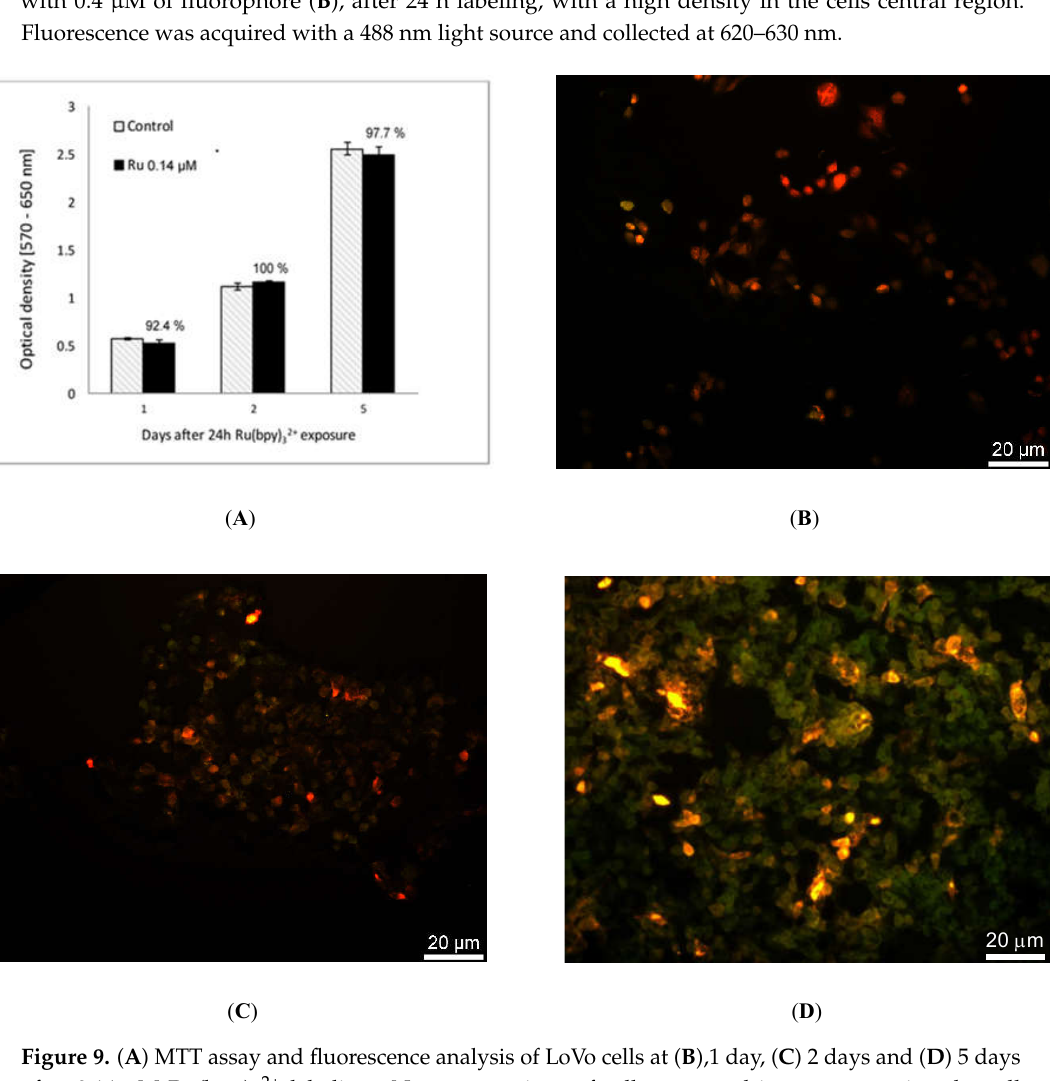
Figure 9. ( A ) MTT assay and fluorescence analysis of LoVo cells at ( B ),1 day, ( C ) 2 days and ( D ) 5 days after 0.14 μM Ru(bpy) 32+ labeling. New generations of cells appeared in green, proving the cell proliferation and detailing the kinetics of fluorophore segregation. Fluorescence was acquired with a 488 nm light source and collected at 620–630 nm.